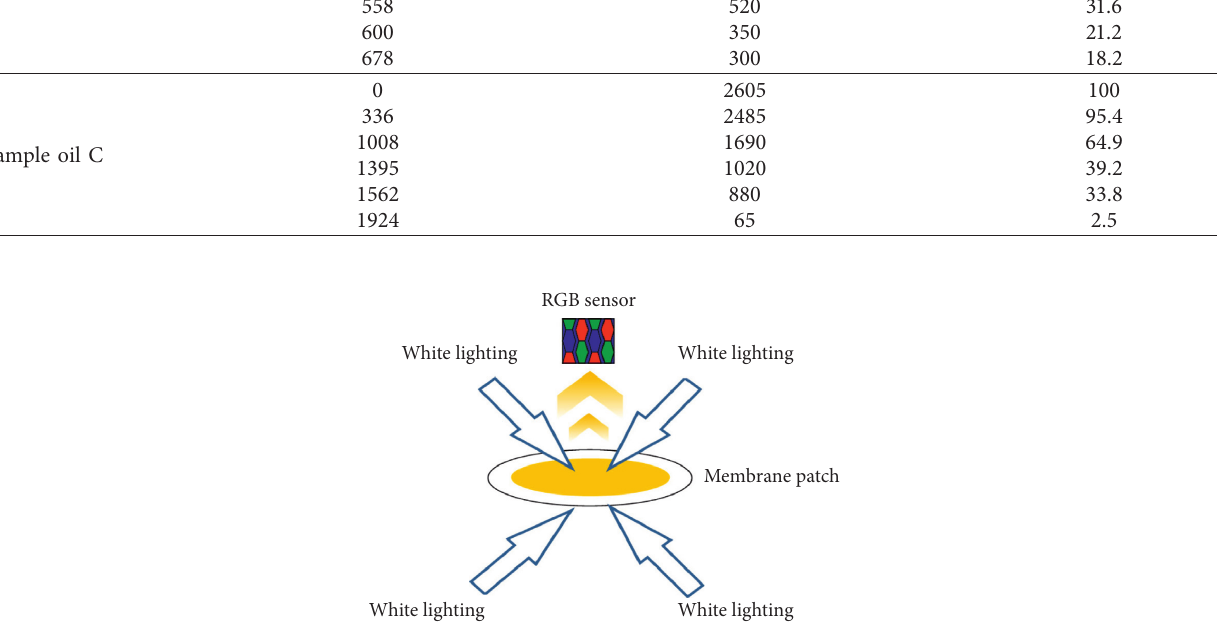
Figure 3: Measurement principle of the